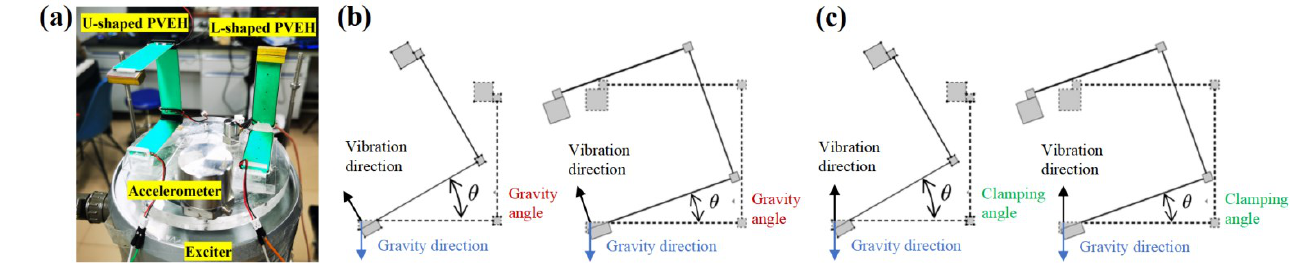
Figure 5. ( a ) Prototype of PVEHs. ( b ) Schematic of the gravity angle. ( c ) Schematic of the clamping angle.